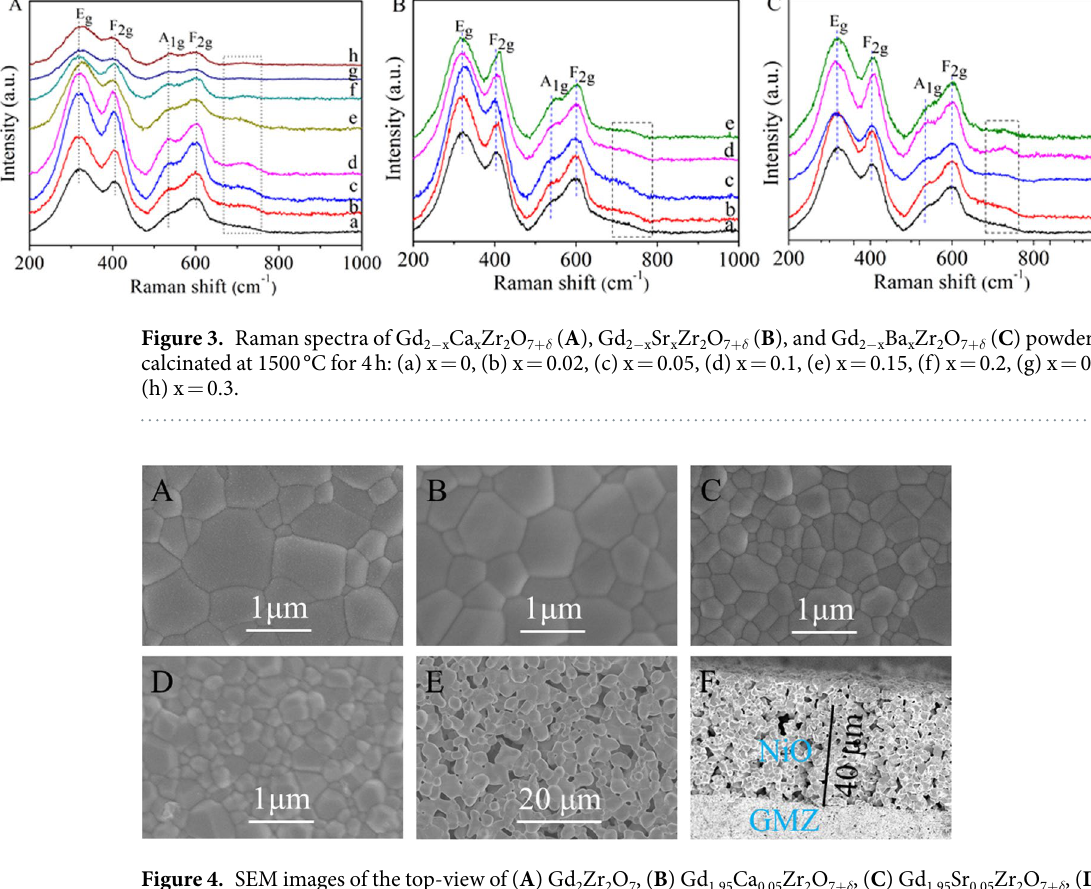
from Fig. 3A, the Raman spectra of Gd 2 − x Ca x Zr 2 O 7- δ (0.2 < x ≤ 0.3) is reduced to a broad continuum of density of states. It has been reported that the Raman spectra of the defect fluorites (A 0.5 B 0.5 O 1.75 ) has a single broad band as the seven oxygen ions in the fluorite structure are randomly distributed over the eight anion sites 40 . This implies that the phase transition from pyrochlore to defect fluorite has happened for Gd 2 − x Ca x Zr 2 O 7- δ (0.2 < x ≤ 0.3) samples, which is agreement with the XRD result above. In addition, a new band is observed at around 720 cm − 1 when M is introduced at the A site of the lattice. This new vibrational mode is assigned to the M–O symmetrical stretch vibration. These results further confirm that M is introduced to the A site of the lattice. The microstructures of Gd 2 − x M x Zr 2 O 7 +δ pellets sintered at 1500 °C for 4 h are given in Fig. 4. As shown, Gd 2 − x M x Zr 2 O 7 +δ substrates prepared by hydrothermal method present the dense pores with a clear boundary during the grains. Pores are seldom found in the grain boundaries. The surface morphology of Gd 2 Zr 2 O 7 exhib- ited non-uniform grain structure, high density and homogeneous surface with the grain size in the range of 0.2–1.2 μ m. With M 2 + dopped, the average grain size of the pellets begins to decrease. The average grain size of Gd 1.95 M 0.05 Zr 2 O 7 +δ (M = Ca, Sr, Ba) pellets is in the range of 0.2–1 μ m, 0.1–0.8 μ m, and 0.05–0.6 μ m, respectively. It should be noted that the Gd 1.95 Ca 0.05 Zr 2 O 7 +δ pellet exhibits relatively fine grains of 0.2–1 μ m in size as shown in Fig. 4B, as compared with other ones of Gd 1.95 Sr 0.05 Zr 2 O 7 +δ and Gd 1.95 Ba 0.05 Zr 2 O 7 +δ of which secondary per- ovskite phase (SrZrO 3 and BaZrO 3 ) seems to appear. To confirm the form of perovskite structure, the BSE image of Gd 1.8 Sr 0.2 Zr 2 O 7 + δ with higher doped concentration for better observation as a good case is shown in Fig. 5. SEM photomicrograph of Gd 1.8 Sr 0.2 Zr 2 O 7 + δ is shown in Fig. 5A. The micrograph manifests heterogeneous grain struc- tures, which could be second phase SrZrO 3 . The BSE image of the same location (Fig. 5B) exhibits high contrast, corresponding to the heterogeneous grain regions of the SE image. To confirm the heterogeneous grain, X-ray mapping was carried out, as shown in Fig. 5C,D,E and F. The heterogeneous grain in the BSE image is found to be rich in gadolinium, zirconium, strontium, and oxygen. The element alanalysis displays that the atomic ratio of the second phase for Sr: Zr: O is close to 1: 1: 3, suggesting that the second phase could be perovskite SrZrO 3 , which is in agreement with the result of XRD. We speculate that the form of perovskite structure CaZrO 3 , SrZrO 3 and BaZrO 3 can influence the sensing performance of the sensors based on Gd 1.95 M 0.05 Zr 2 O 7 +δ substrates. Figure 4C and D shows the SEM photographs of NiO sensitive electrode calcined at 1400 °C for 2 h and the cross-section for porous layer in view of the sensor based on Gd 1.95 Ca 0.05 Zr 2 O 7 +δ substrates, respectively. It is observed that the surface of NiO SE shows a porous and three-dimensional network structure, which is in favor of prolonging the